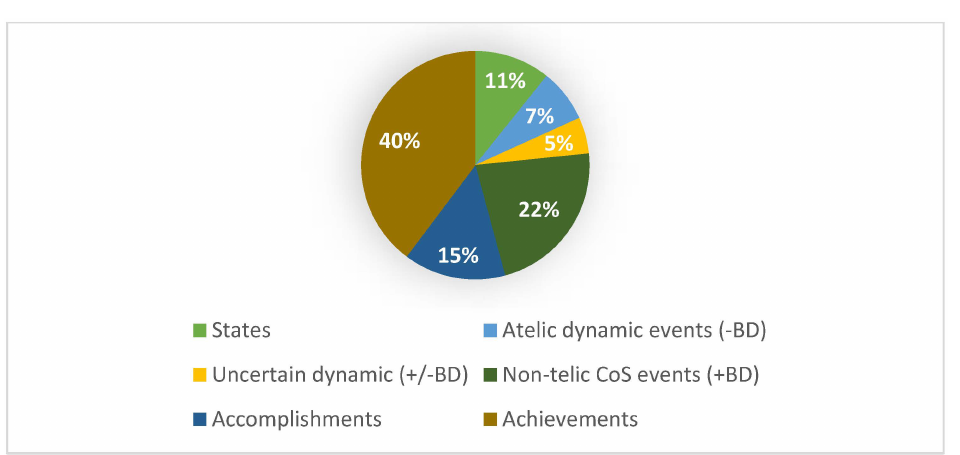
Figure 2. Event structure composition of our zero-inflected